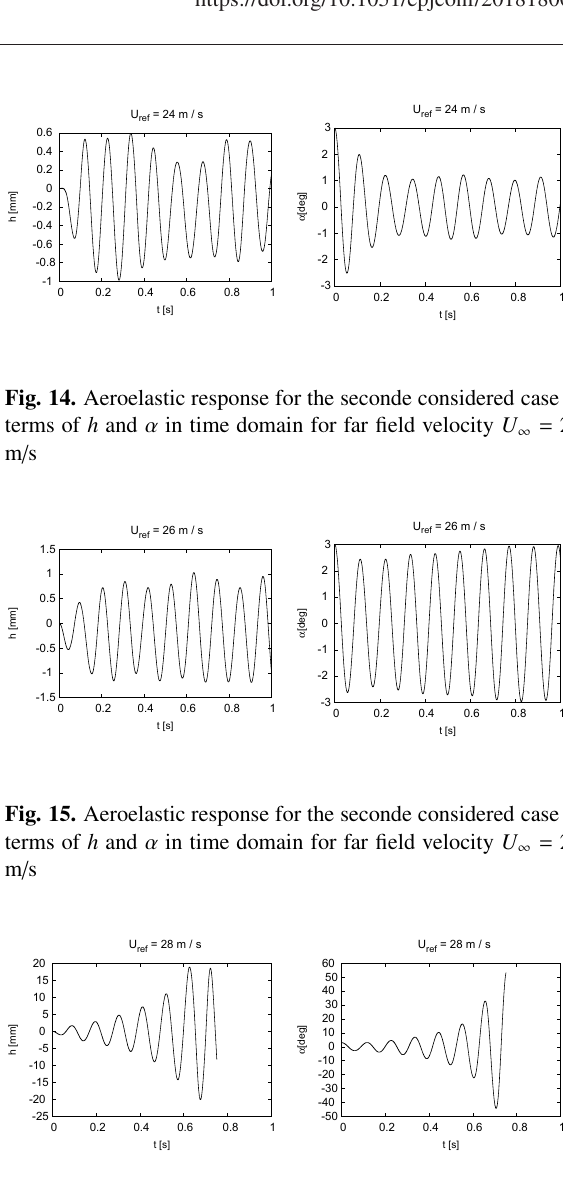
Fig. 12. Aeroelastic response for the seconde considered case in terms of h and α in time domain for far field velocity U ∞ = 20 m / s